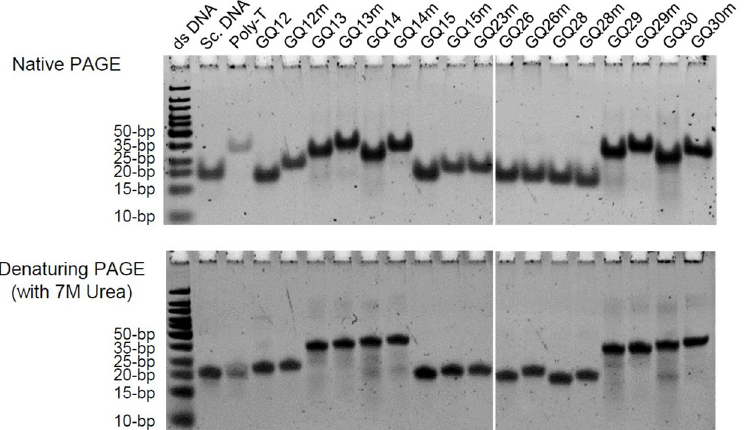
Fig 6. Non-denaturing polyacrylamide gel electrophoresis (PAGE) analysis of GQ oligonucleotides. Wild-type and mutant ORF14 GQ ODNs (1 μ M) were subjected to native PAGE analyses after annealing in 100 mM K + buffer (top) or denaturing PAGE with 7M urea (bottom). Scrambled (Sc DNA; 5 0 -TAACCGATGATATGAGTCAGATATAT-3 0 ) and poly-T ODNs (Poly-T; 26mer) used as controls are shown. Double-stranded DNA (ds DNA) size makers are